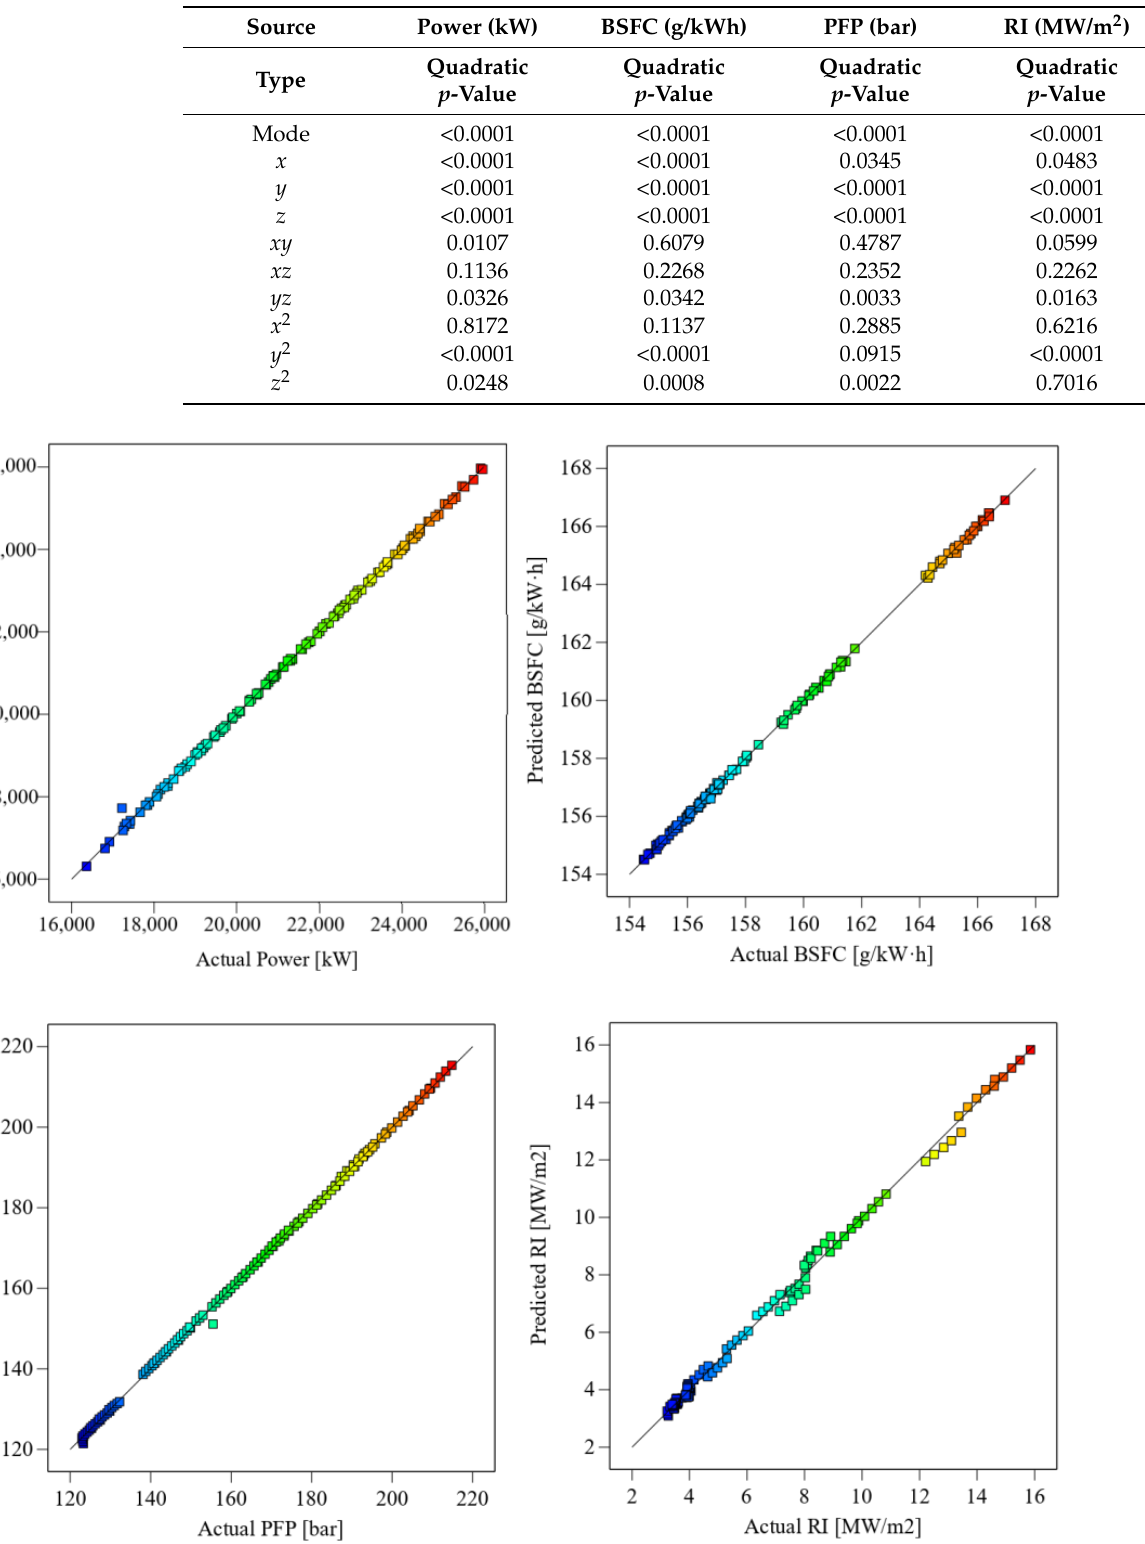
Table 5. Analysis of variance table.